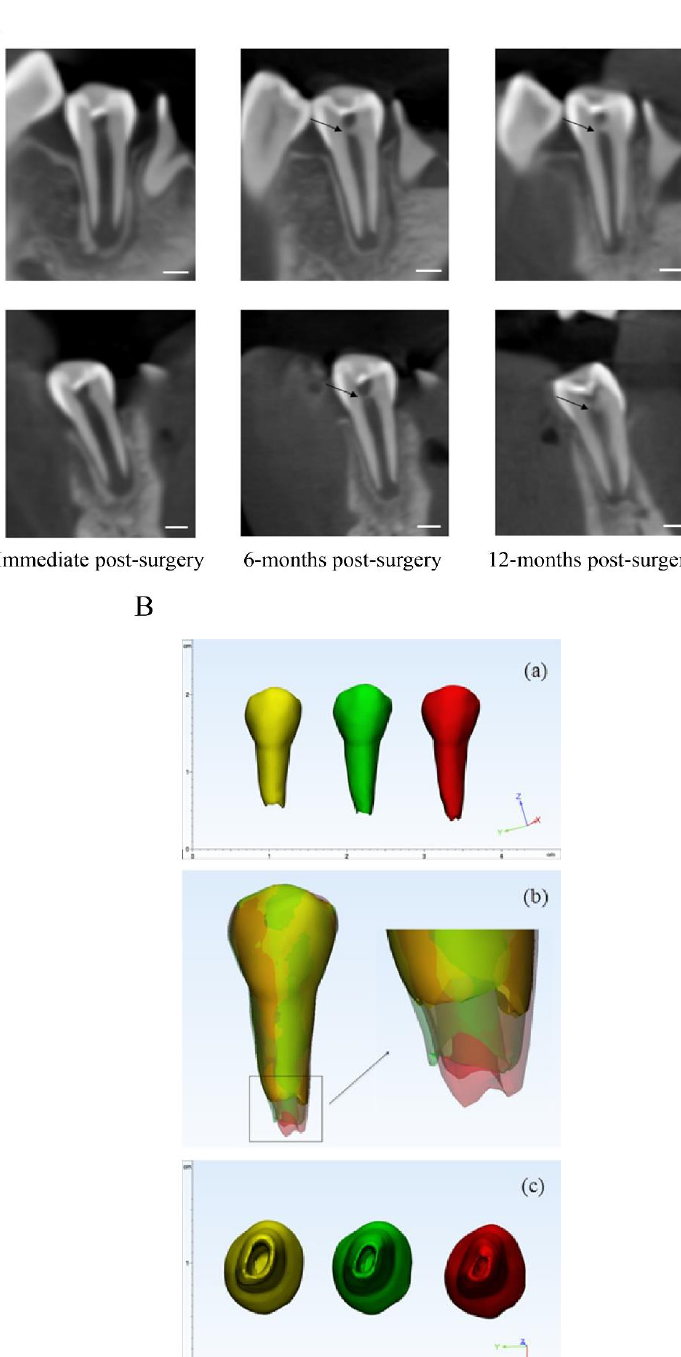
Figure 4. Representative images of an acemannan treated tooth; ( A ): radiograph image in the sagittal and coronal views of the tooth immediately post-surgery, 6-months post-surgery, and 12-months post-surgery. Dentine bridge (black arrow) and continued root formation were observed at 6- and 12-months follow-up in a time-dependent manner. ( B ): ( a ) 3D reconstructed tooth immediately post-surgery (yellow), 6-months post-surgery (green), and 12-months post-surgery (red). Increased root development post-treatment was observed; ( b ) the superimposed 3D tooth immediately, 6-months, and 12-months post-surgery. The enlarged image demonstrates the root apex position and root canal shape of the tooth; ( c ) the apical view of the tooth in 3 time points. The narrowing of the apical foramen is demonstrated in a time-dependent manner. Scale bar = 3